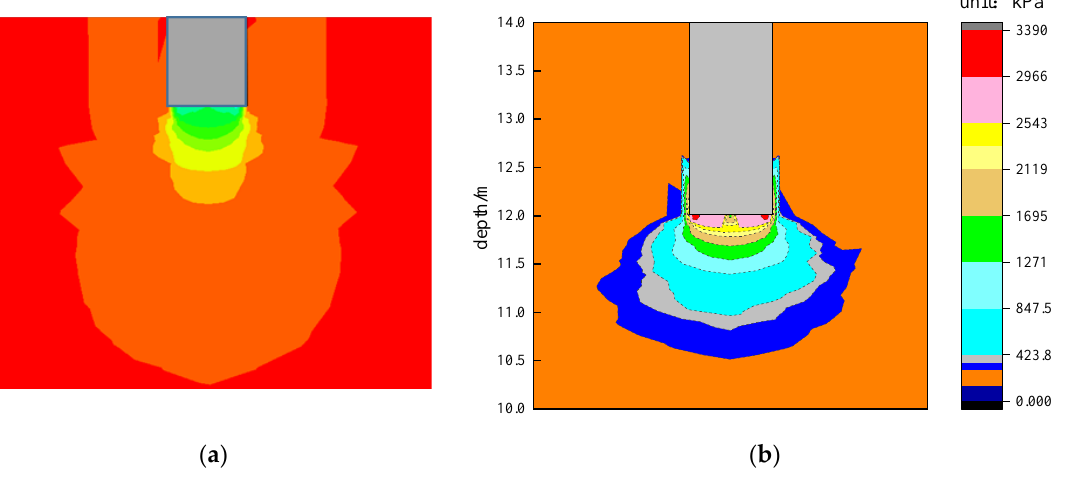
Figure 14. Vertical stress nephogram of mudstone at the pile tip. ( a ) Vertical stress cloud diagram of pile end mudstone; ( b ) The optimized vertical stress cloud diagram of pile end mudstone.